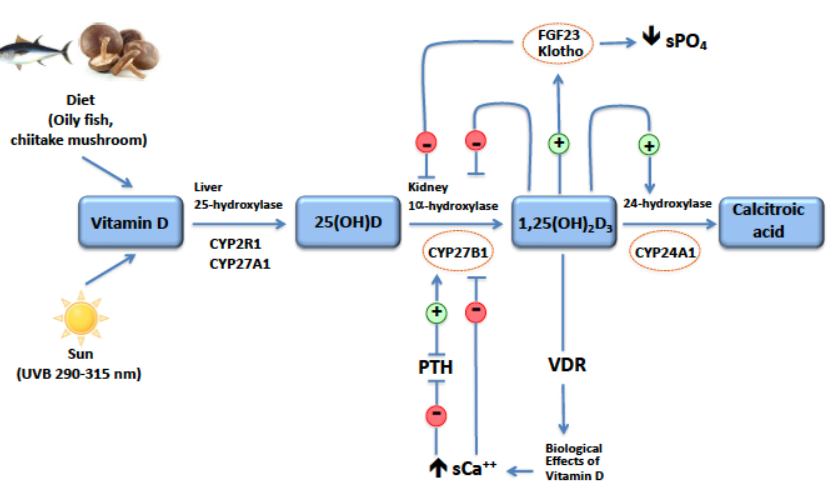
Figure 1. There are the following two sources of vitamin D in the diet: either D3, which can be found in oily fish, or D2, which is present in some kinds of mushrooms. Additionally, the other source is from the conversion of 7-dehydrocholesterol into vitamin D in the skin by the sun through a specific UVB light (290–315 nm wavelength). This is the major source, providing more than 70–80% of our daily vitamin D needs. These Vitamin Ds (D2 and D3) are transformed in 25(OH)D in the liver by the following two enzymes: CYP2R1 and CYP27A1. The two enzymes are down-regulated by uremic toxins and high PTH. Then, 25 vitamin D is converted in the kidney to 1,25-dihydroxyvitamin D3 [1,25-(OH)2D3] by 1α-hydroxylase or CYP27B1. Additionally, lastly, 1,25-dihydroxyvitamin D is degraded to calcitroic acid by the 24-hydroxylase, or CYP24A1. CYP27B1 is tightly regulated by